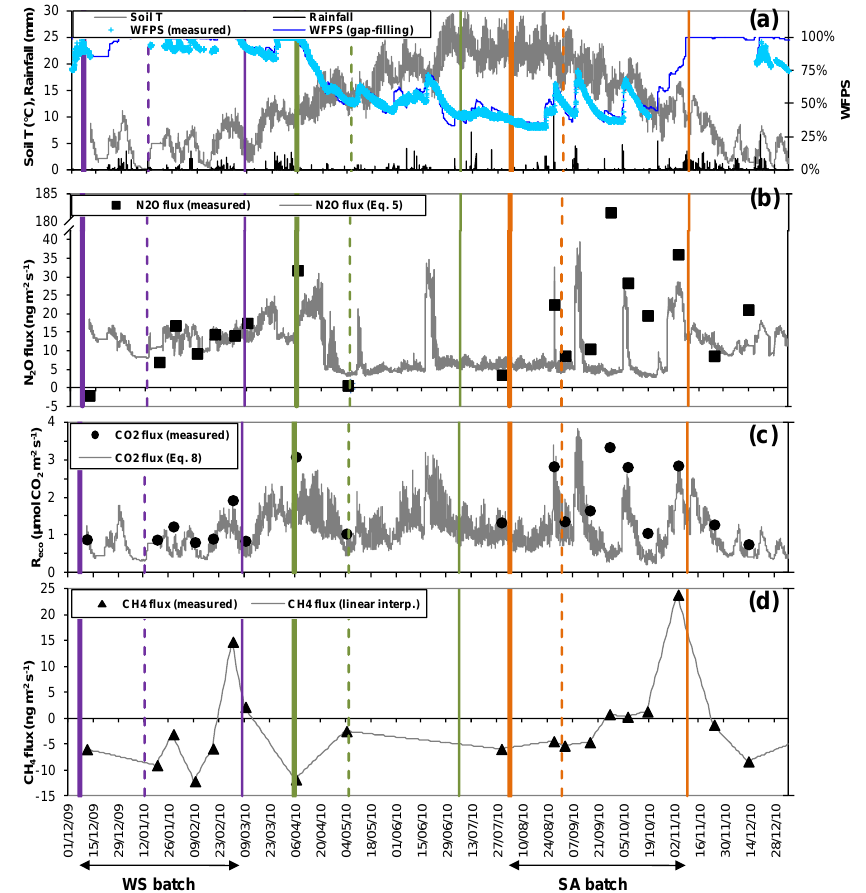
Fig. 2. Overview of soil conditions, meteorology, measured (black symbols) and gap-filled (grey lines) GHG fluxes at the outdoor run scale. (a) Soil temperature at − 5cm depth (Soil T ), rainfall and water-filled pore space (WFPS). (b) N 2 O fluxes. (c) Ecosystem respiration ( R eco ) . (d) CH 4 fluxes. GHG fluxes for each measurement day are spatial integrals computed from individual measurements using geostatistical methods. Vertical lines indicate batch start (thick, continuous), broilers first outdoor access (dotted) and slaughter (thin,